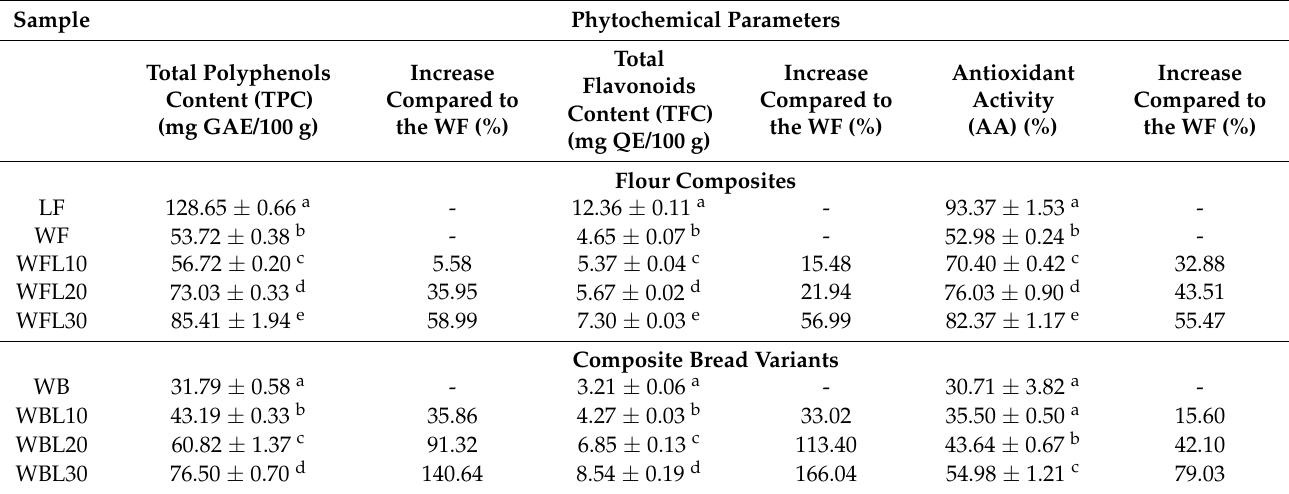
Table 3. Phytochemical profile of lupin flour composites and